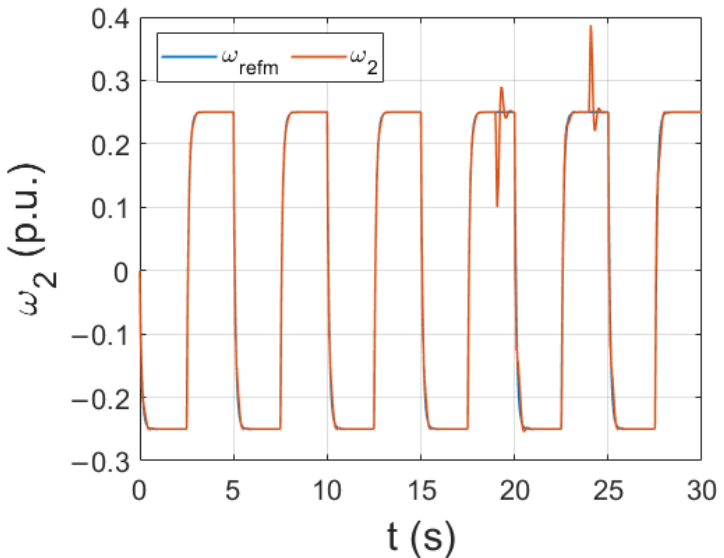
Figure 3. Operation of the drive under nominal conditions—rotational speed of the load